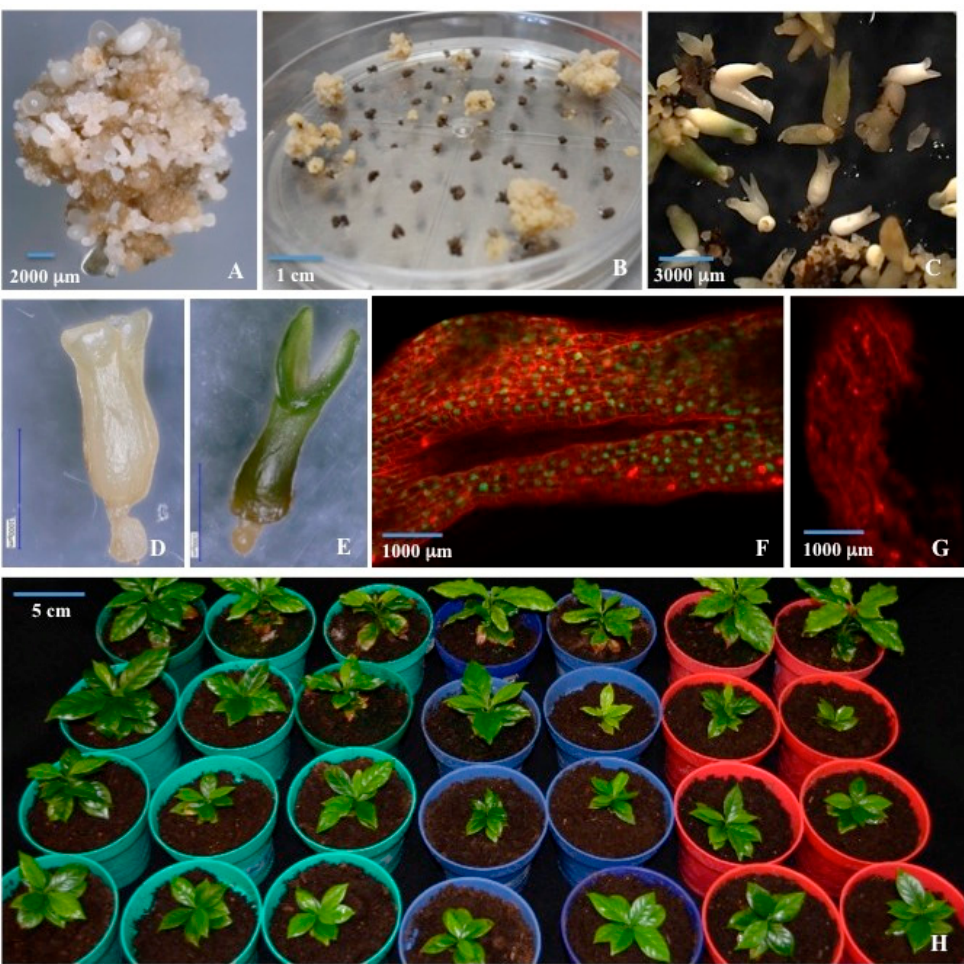
Figure 2. ( A ) C. arabica embryogenic calli induced from leaf explants used for stable genetic transformation. ( B ) Hygromycin-resistant embryogenic calli of C. arabica derived from bombarded globular structures after four months of selection, showing independent events of genetic transformation. ( C ) Somatic embryos under osmotic stress in the first month of maturation. ( D , E ) Individual somatic embryo under osmotic stress in the second month of maturation. Scale bar 1000 µ m. ( F ) Green fluorescent protein (GFP) stable expression in nuclei of transgenic mature somatic embryos of C. arabica , after three months of growth on 50 mg / L hygromycin-containing medium. ( G ) Control somatic embryo, showing no GFP expression. ( H ) Regenerated plants of C. arabica after six months in soil conditions. Wild-type plants in red pots, transgenic plants in green and blue pots.